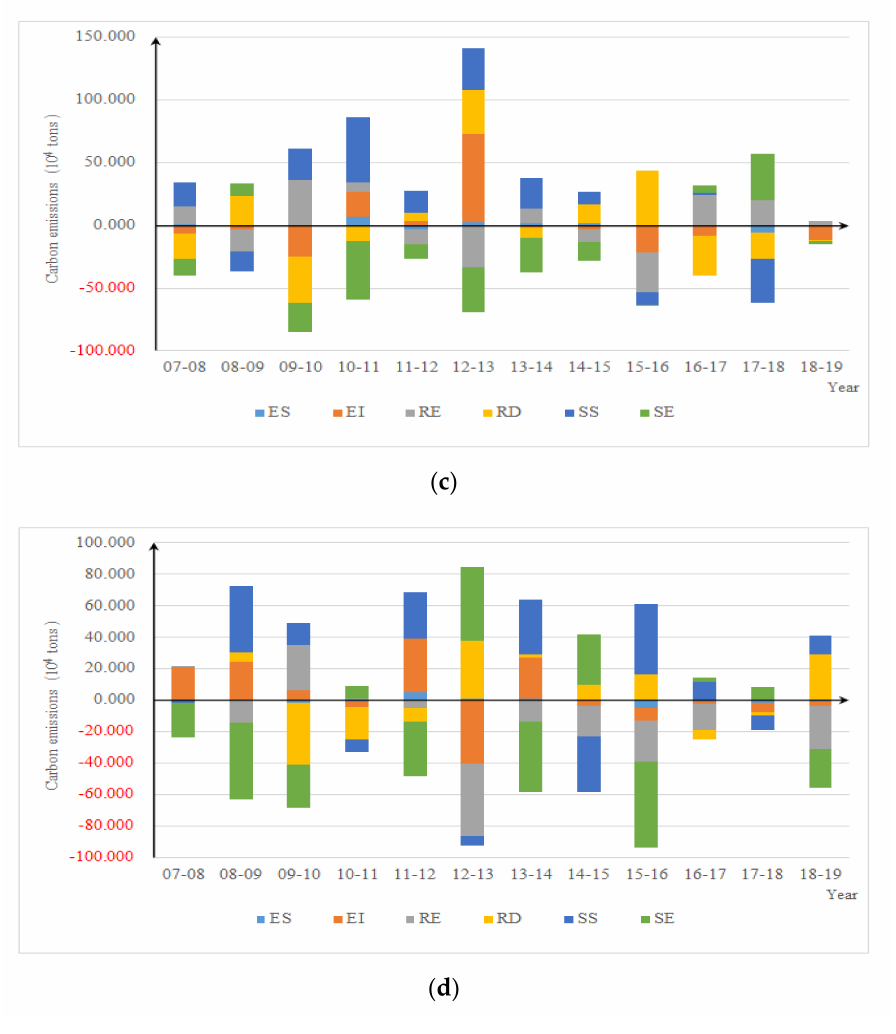
Figure 6. Comparative analysis of the decomposition results. ( a ) The overall results of land urbaniza- tion factors on three regions; ( b ) the catch-up effect decomposition results of the eastern region; ( c ) the catch-up effect decomposition results of the central region; ( d ) the catch-up effect decomposition results of the western